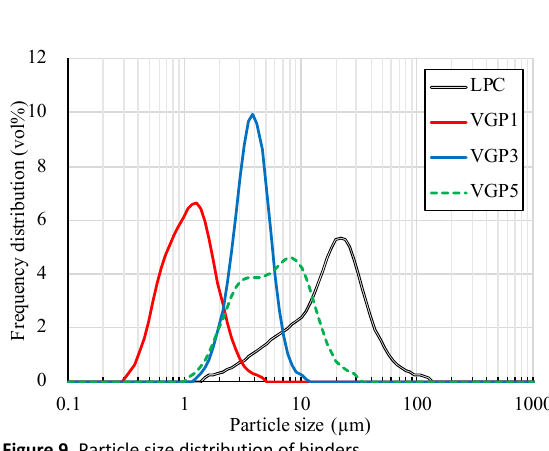
Figure 9. Particle size distribution of binders.